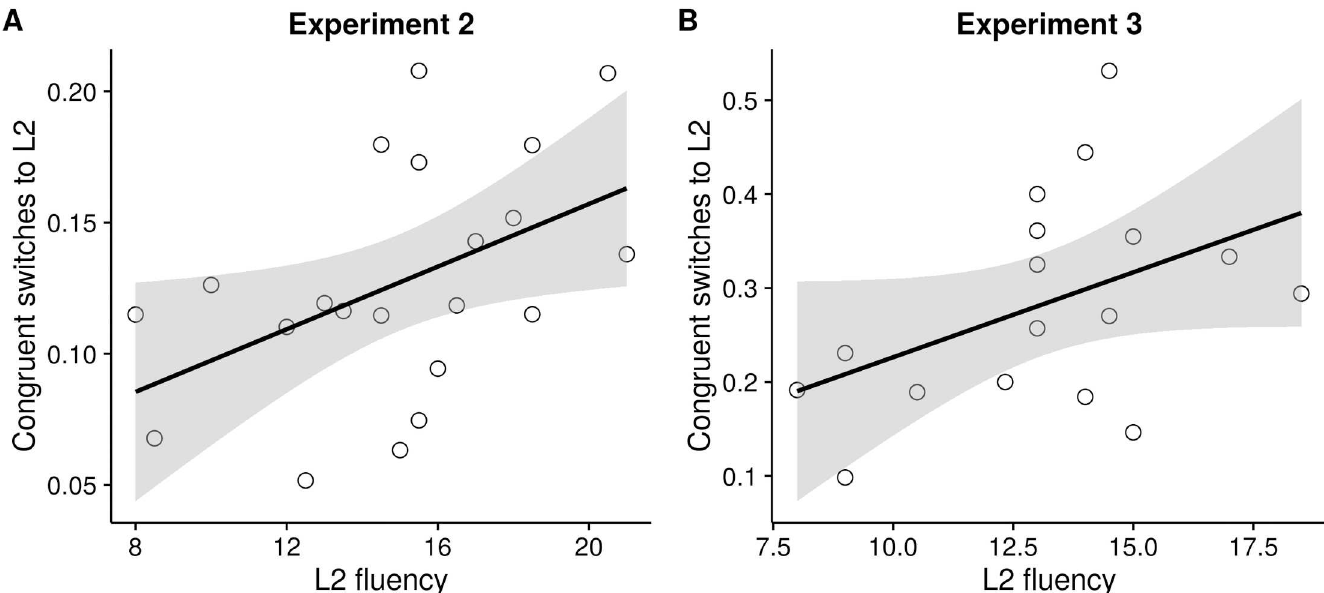
Fig 6. Correlation plot for L2 switch rate (when participants switched to the language indicated by the cartoon) vs L2 fluency for Experiment 2 and